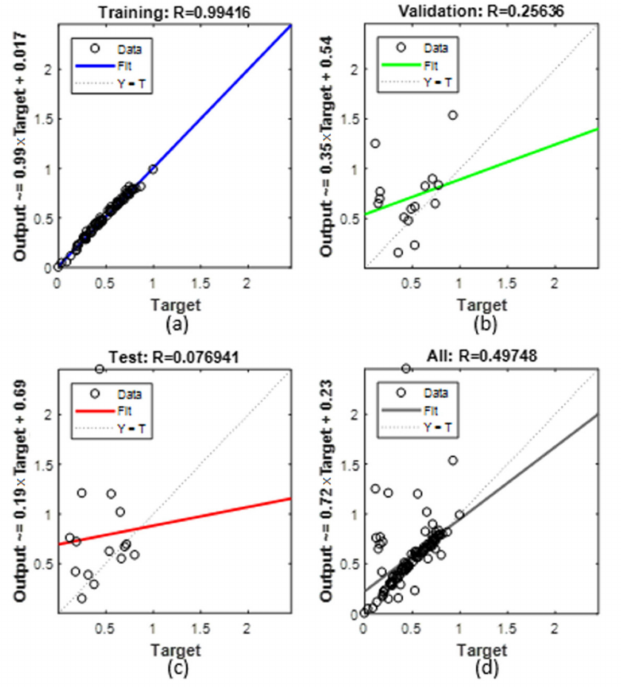
Figure 7. Regression and correlation coefficient using 100 neurons in the hidden layer for stage ( a ) the training phase, ( b ) validation, ( c ) testing, and ( d ) overall. Using 100 neurons in the hidden